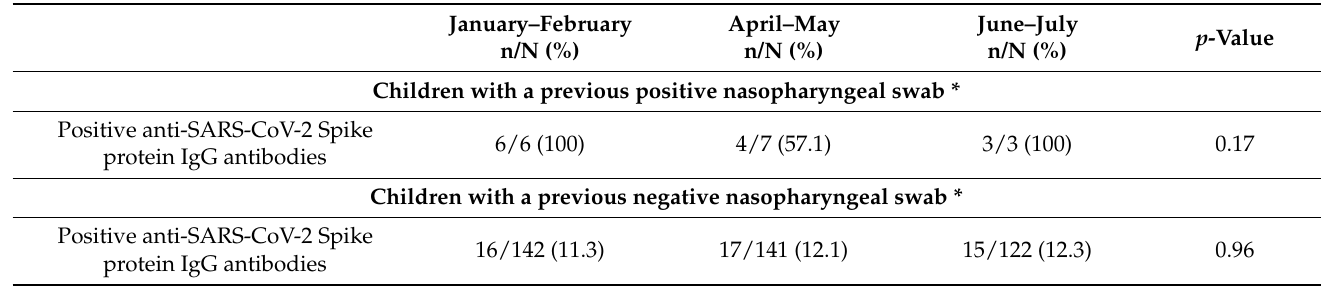
Table 2. Subgroup analysis by results of a previous nasopharyngeal swab.